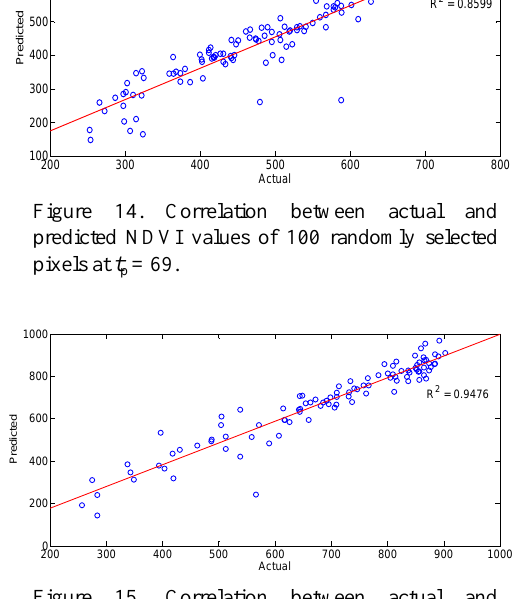
Figure 15. Correlation between actual and predicted NDVI values of 100 randomly selected pixels at t p = 277.